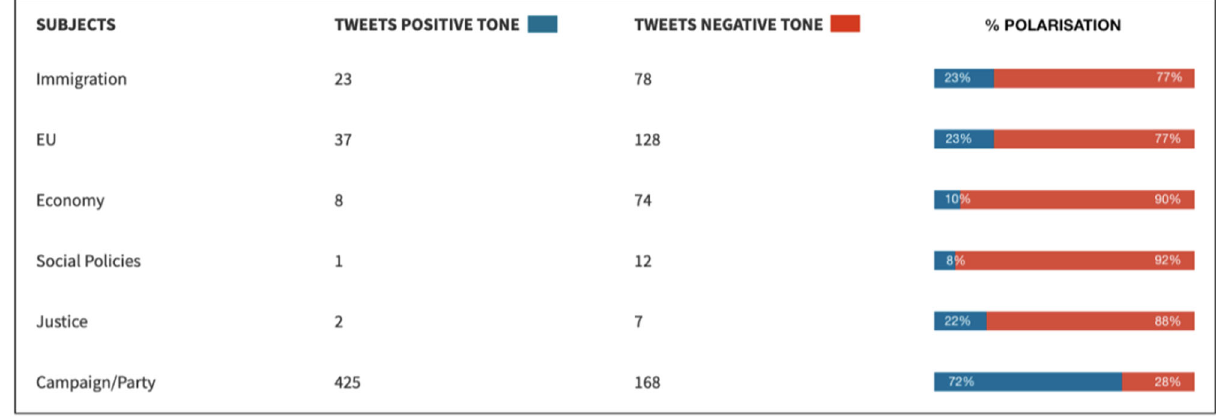
Fig. 8 Evaluation of the tone in which each theme is narrated (2019)/Own